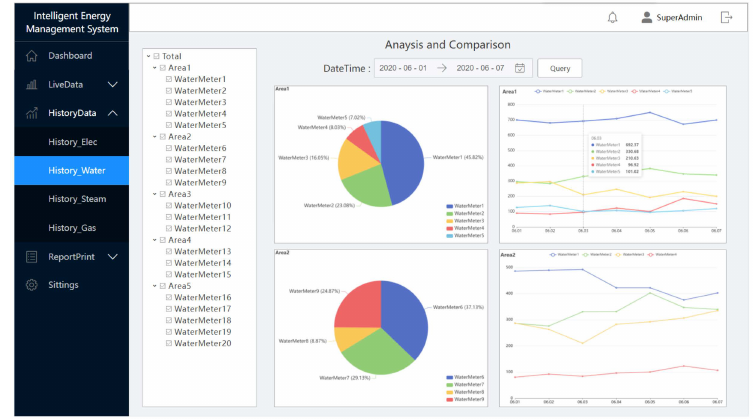
Figure 9. Historical data query interface.